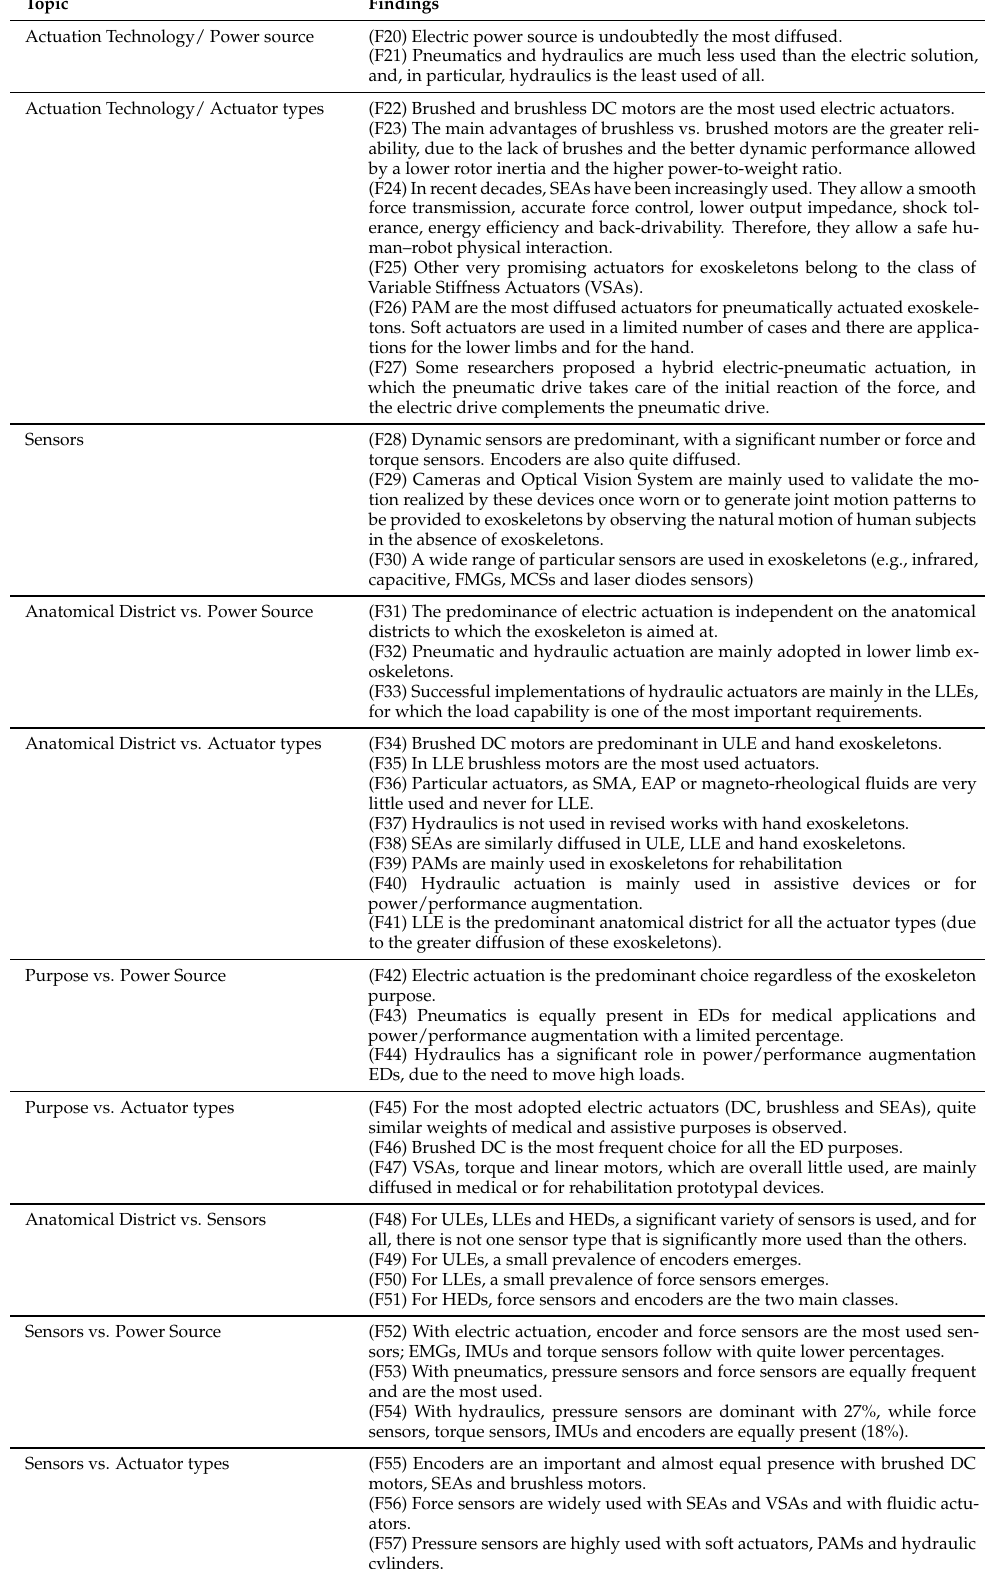
Table 3. Synopsis of the main findings of the analytical